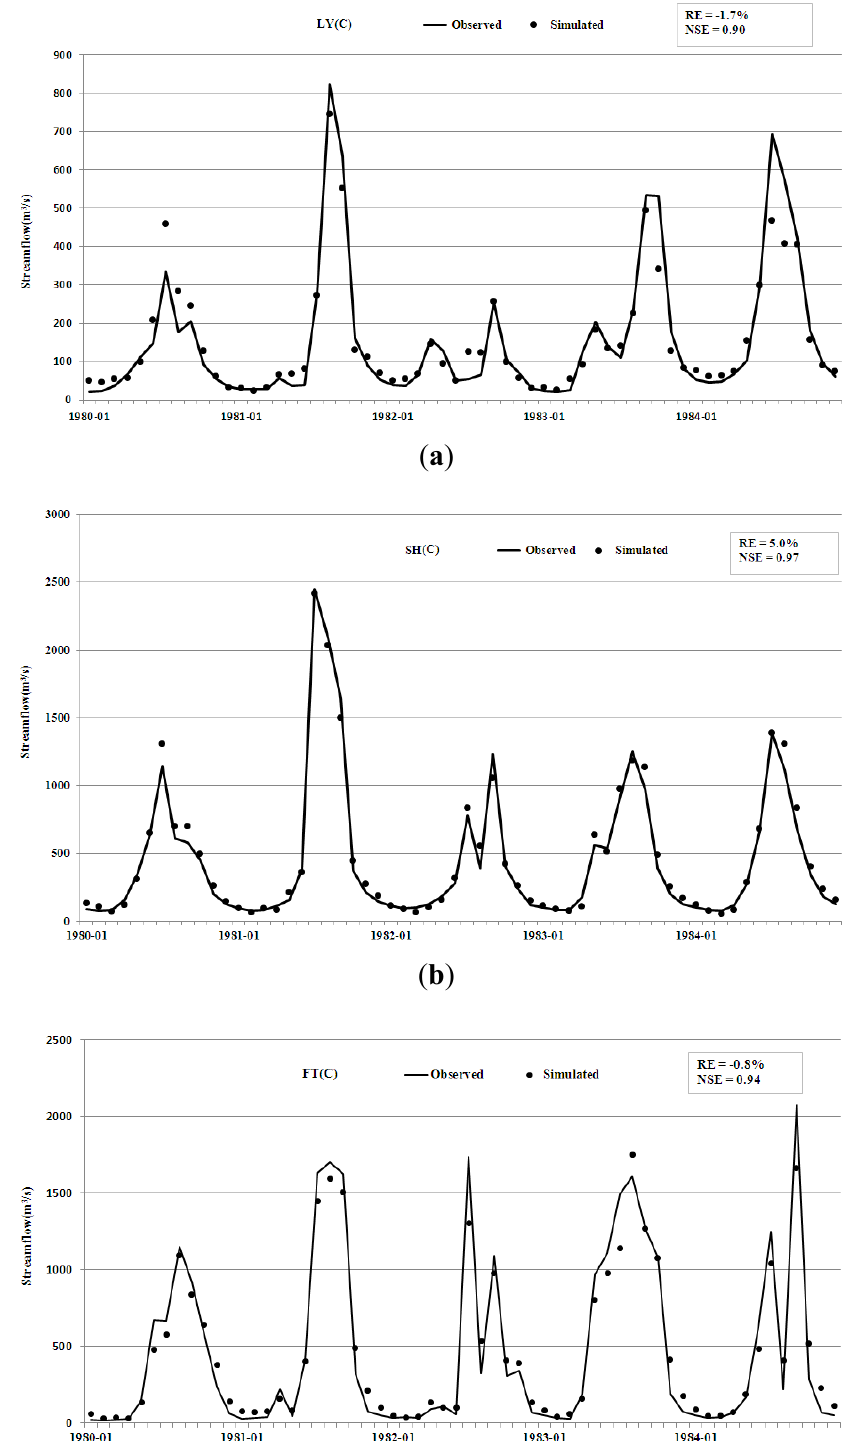
Figure 3. Monthly hydrographs for the calibration and validation periods. RE: relative error; NSE: Nash–Sutcliffe model efficiency coefficient. ( a ) Monthly hydrographs of LY for the calibration period; ( b ) Monthly hydrographs of SH for the calibration period; ( c ) Monthly hydrographs of FT for the calibration period; ( d ) Monthly hydrographs of LY for the validation period; ( e ) Monthly hydrographs of SH for the validation period; ( f ) Monthly hydrographs of FT for the validation